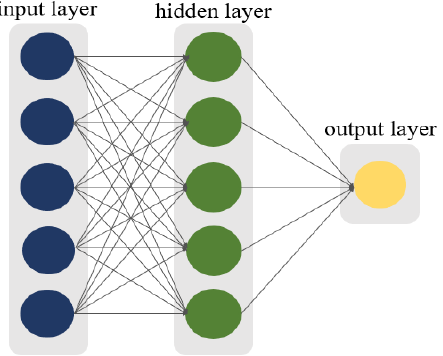
Figure 4. Structure of ANN (artificial neural network).